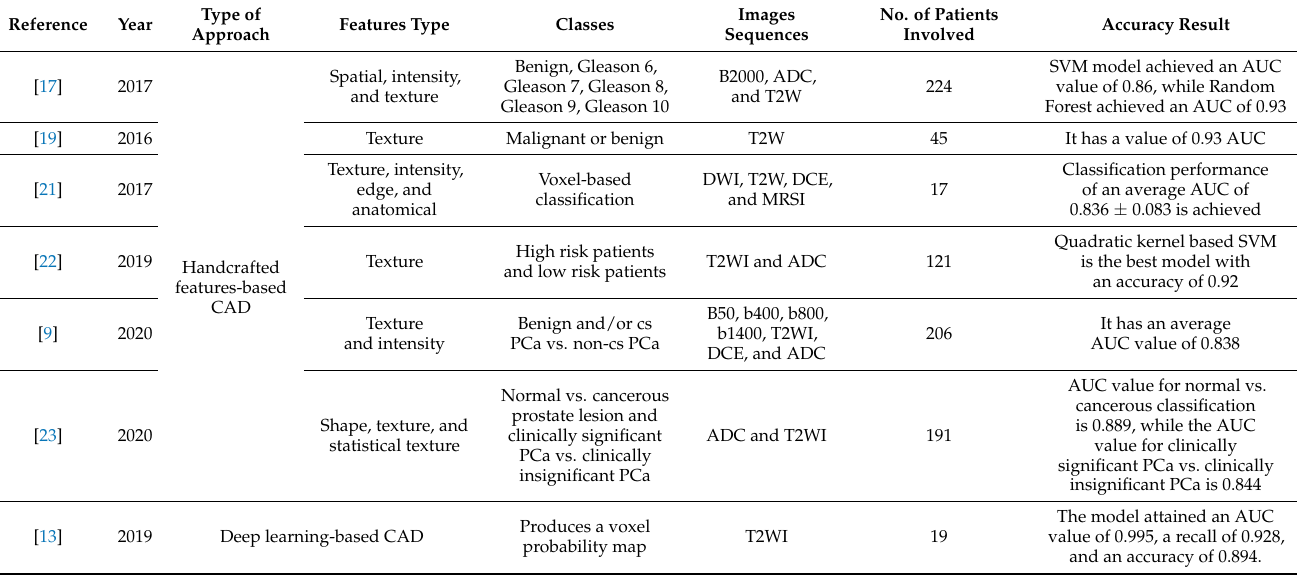
Table 1. A brief comparison between previous prostate MRI CAD